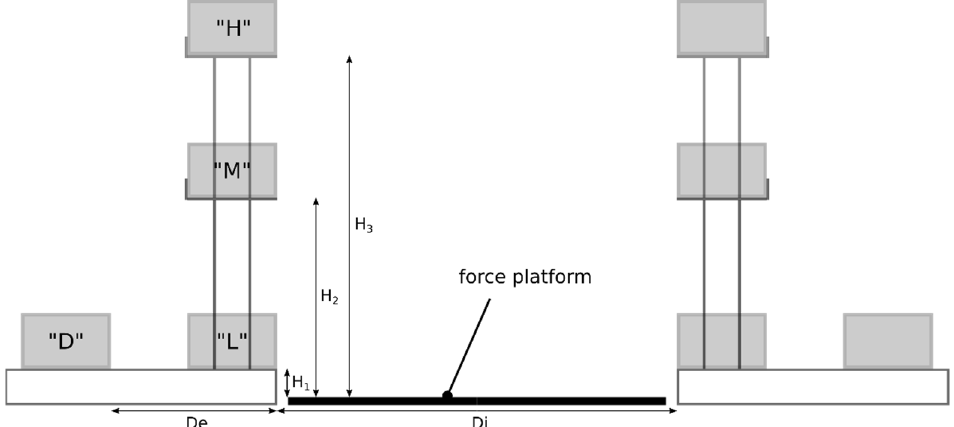
Figure 1. Experimental convertible setup consisting of two areas used for lifting and deposit locations. “D”, “L”, “M”, and “H” indicate the four areas available for both lifting and deposit. H 1 , H 2 , and H 3 indicate the low, middle, and high level of the load, respectively; D e represents the distance of a potential depth; and D i represents the distance between the lifting and the deposit Four or eight repetitions were executed for each experimental condition. For two con-